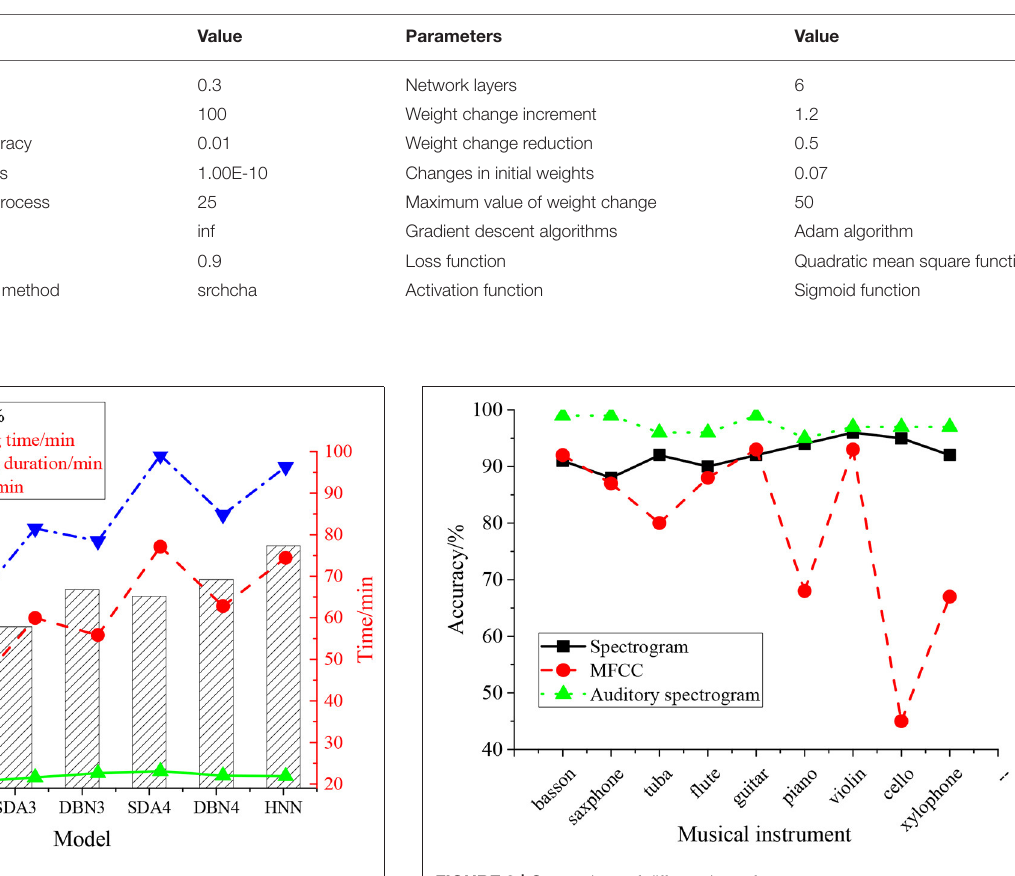
FIGURE 6 | Model accuracy comparison.